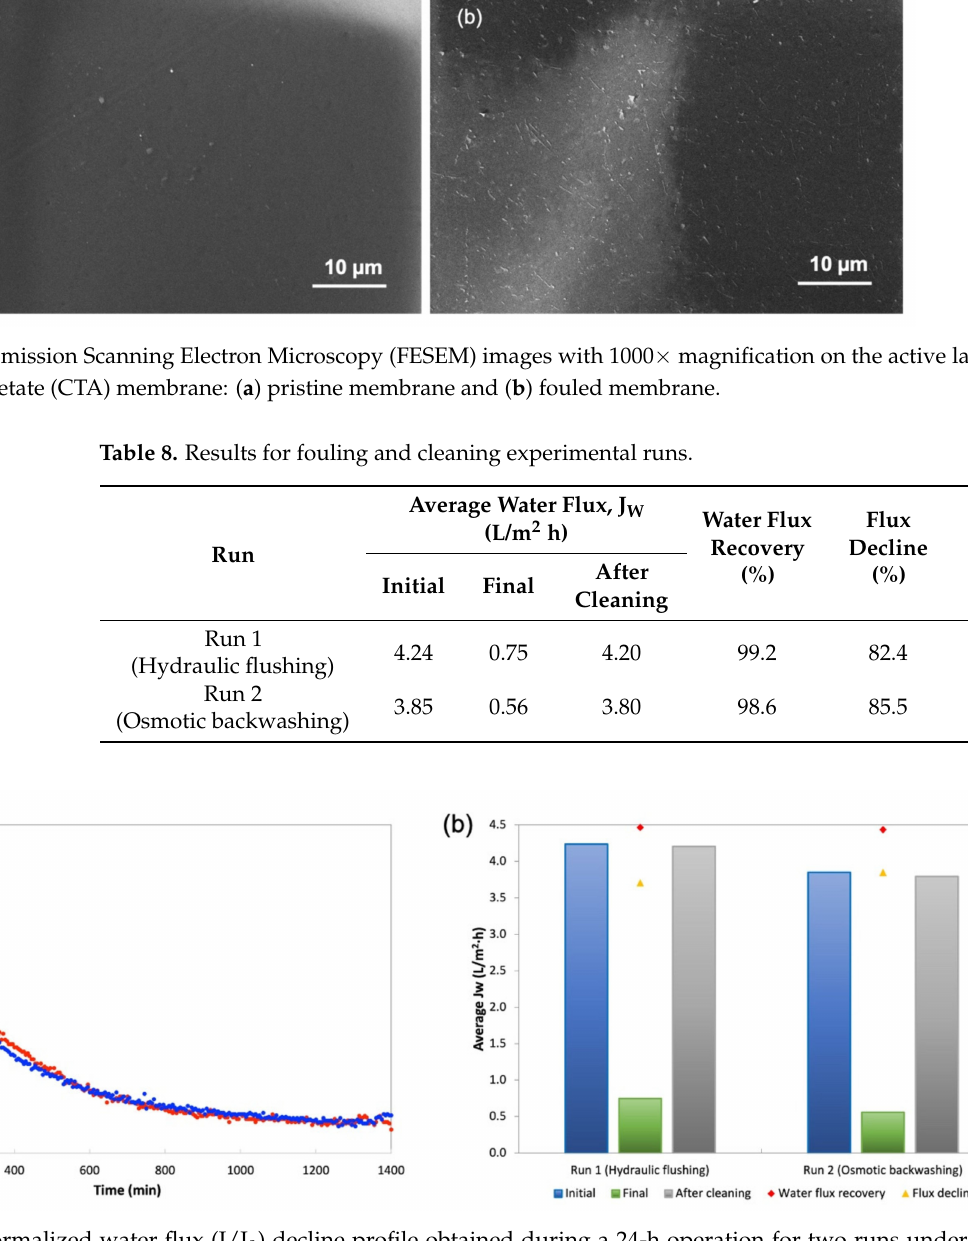
Figure 14. ( a ) Normalized water flux (J/J 0 ) decline profile obtained during a 24-h operation for two runs under same conditions with An-POME as FS and 1 M MAP as DS; ( b ) Average water flux in the initial stage (first 2 h of operation), final stage (final 2 h of operation), after cleaning, flux decline, and water flux recovery after hydraulic flushing and osmotic